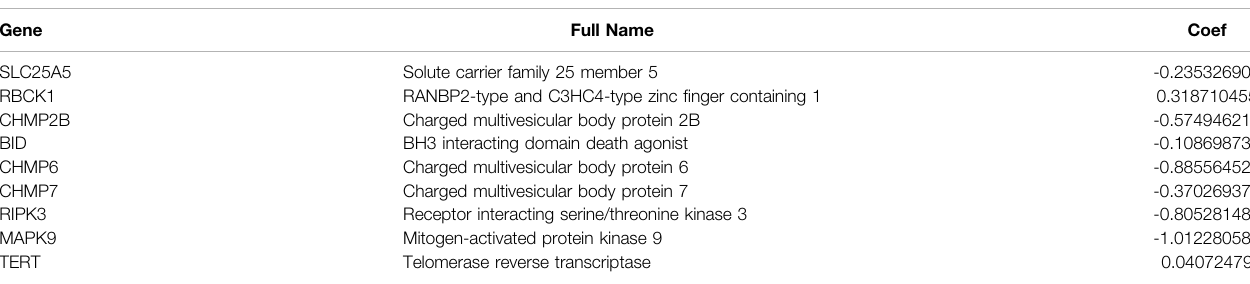
TABLE 2 | Prognostic genes generated by LASSO Cox